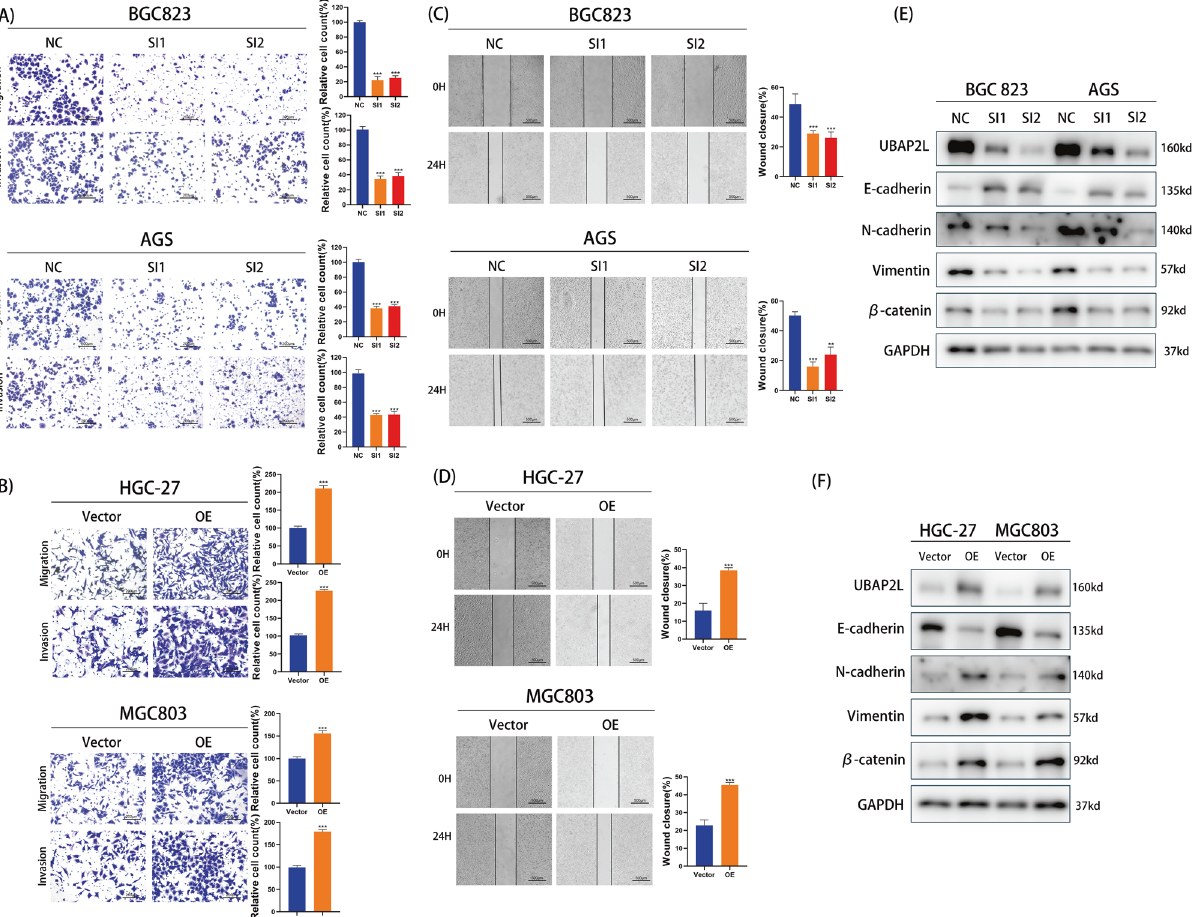
Fig. 3 UBAP2L promotes gastric cancer migration and invasion via EMT. A , B Migrative and invasive capabilities of GC cell lines with UBAP2L knockdown or overexpression was measured by transwell assays. The histogram of relative cell count was exhibited on the right. C , D Wound healing assay was conducted to declare the migration abilities of GC cell lines. The histogram of the percentage of relative wound closure was exhibited on the right. E , F Western blot analyzed the expression of E-cadherin, N-cadherin, Vimentin, and β -catenin in GC cells with different UBAP2L